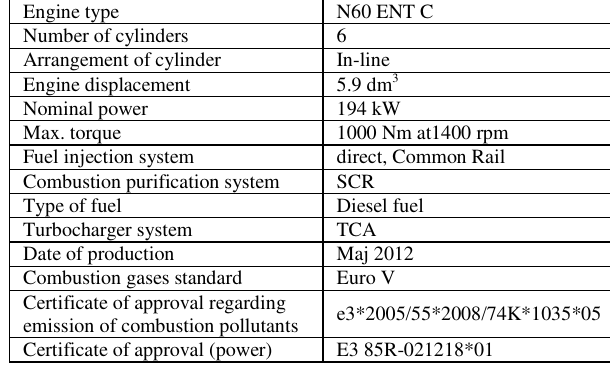
Table 3. Technical data of the tested engine [11]